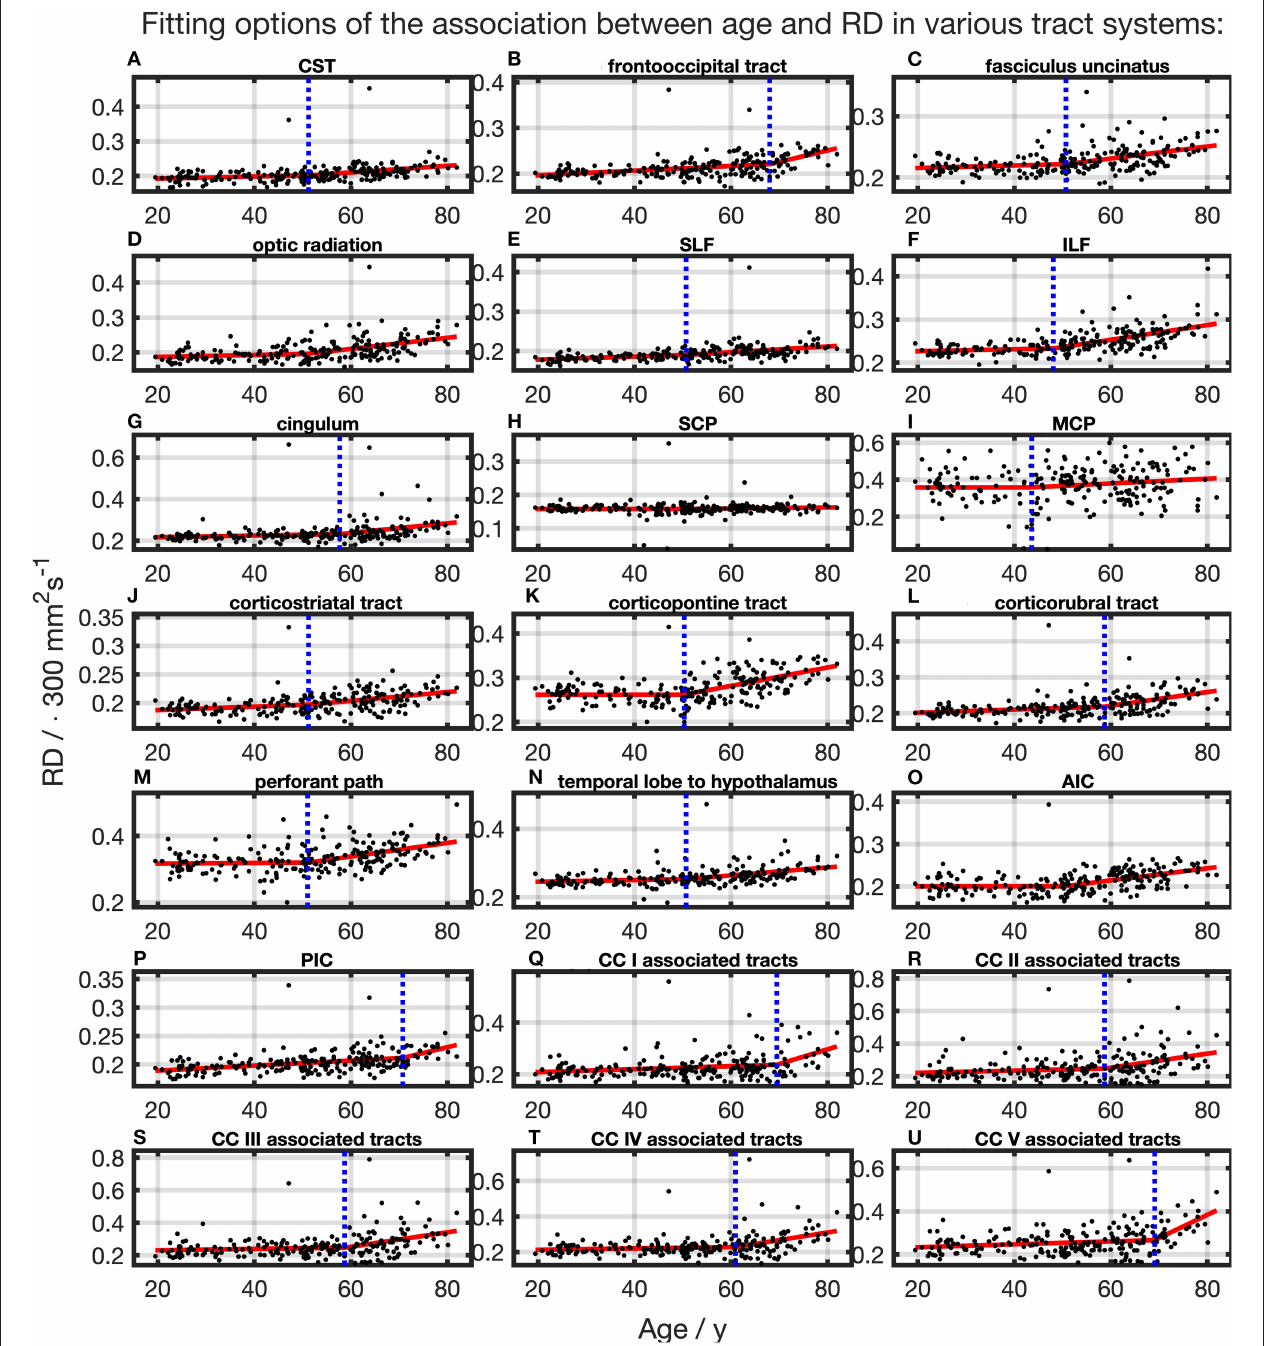
FIGURE 7 | Scatter plots (black) and regression line (red) of the association between age and radial anisotropy (RD) in various tract systems. The fit shown in each case is the one with the highest adjusted R 2 . (H) One linear regression across age span. (A–G,I–U) In all other tract systems: segmented linear regression. The position of the knot between two linear curve segments is given as a blue dashed line (CC, corpus callosum; CST, corticospinal tract; SLF, superior longitudinal fasciculus; ILF, inferior longitudinal fasciculus; SCP, superior cerebellar peduncle; MCP, middle cerebellar peduncle; AIC, anterior limb of internal capsule; PIC, posterior limb of internal